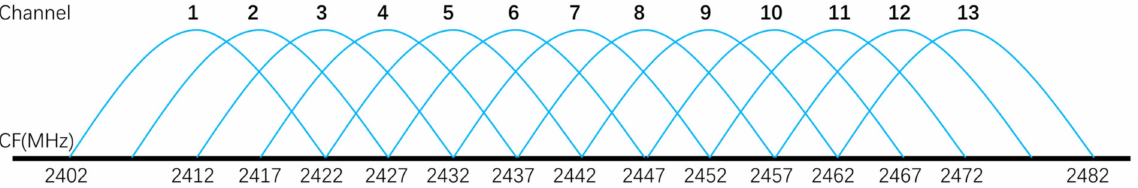
Figure 5. WiFi channel